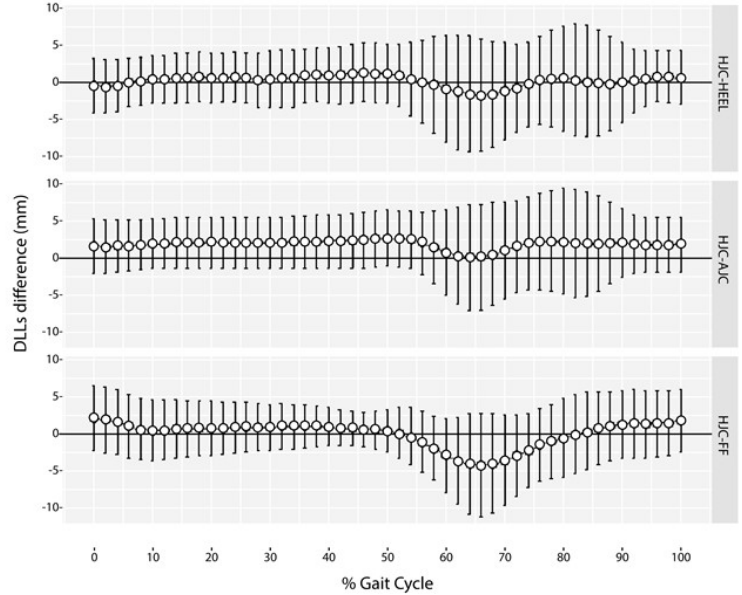
Figure 3. Adjusted 95% confidence intervals for mean average DLLs differences.